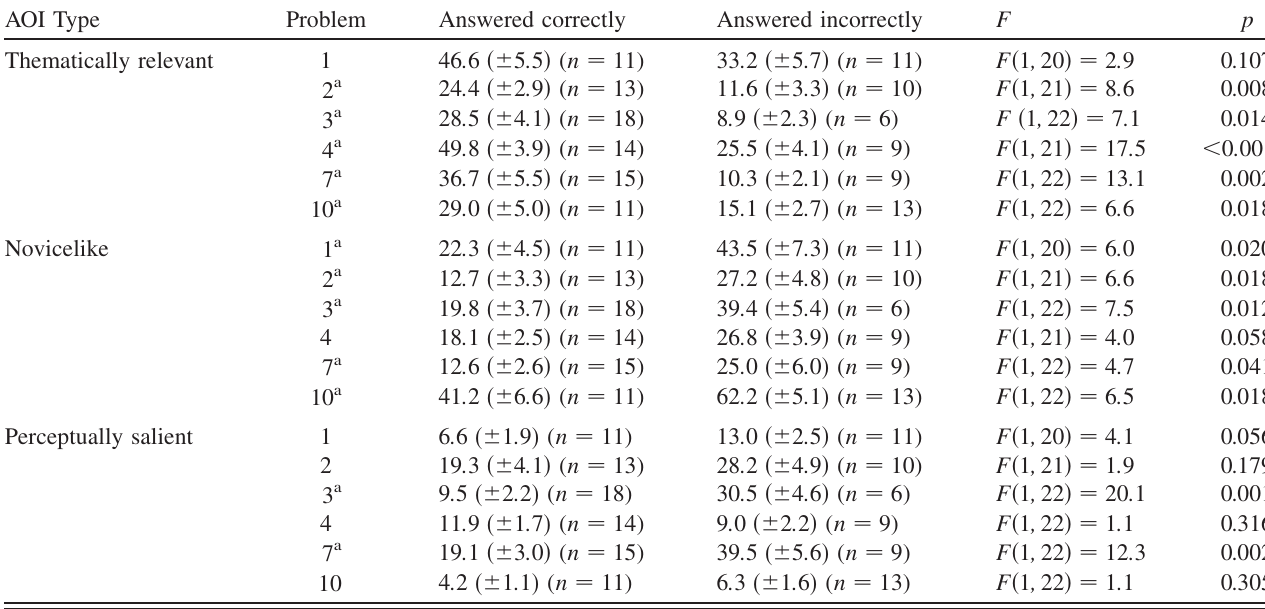
TABLE IV. Mean percentage time spent ( (cid:4) standard error) and results of one-way ANOVA during entire problem period for thematically relevant, novicelike, and perceptually salient AOIs for participants who answered the question correctly or incorrectly. AOI